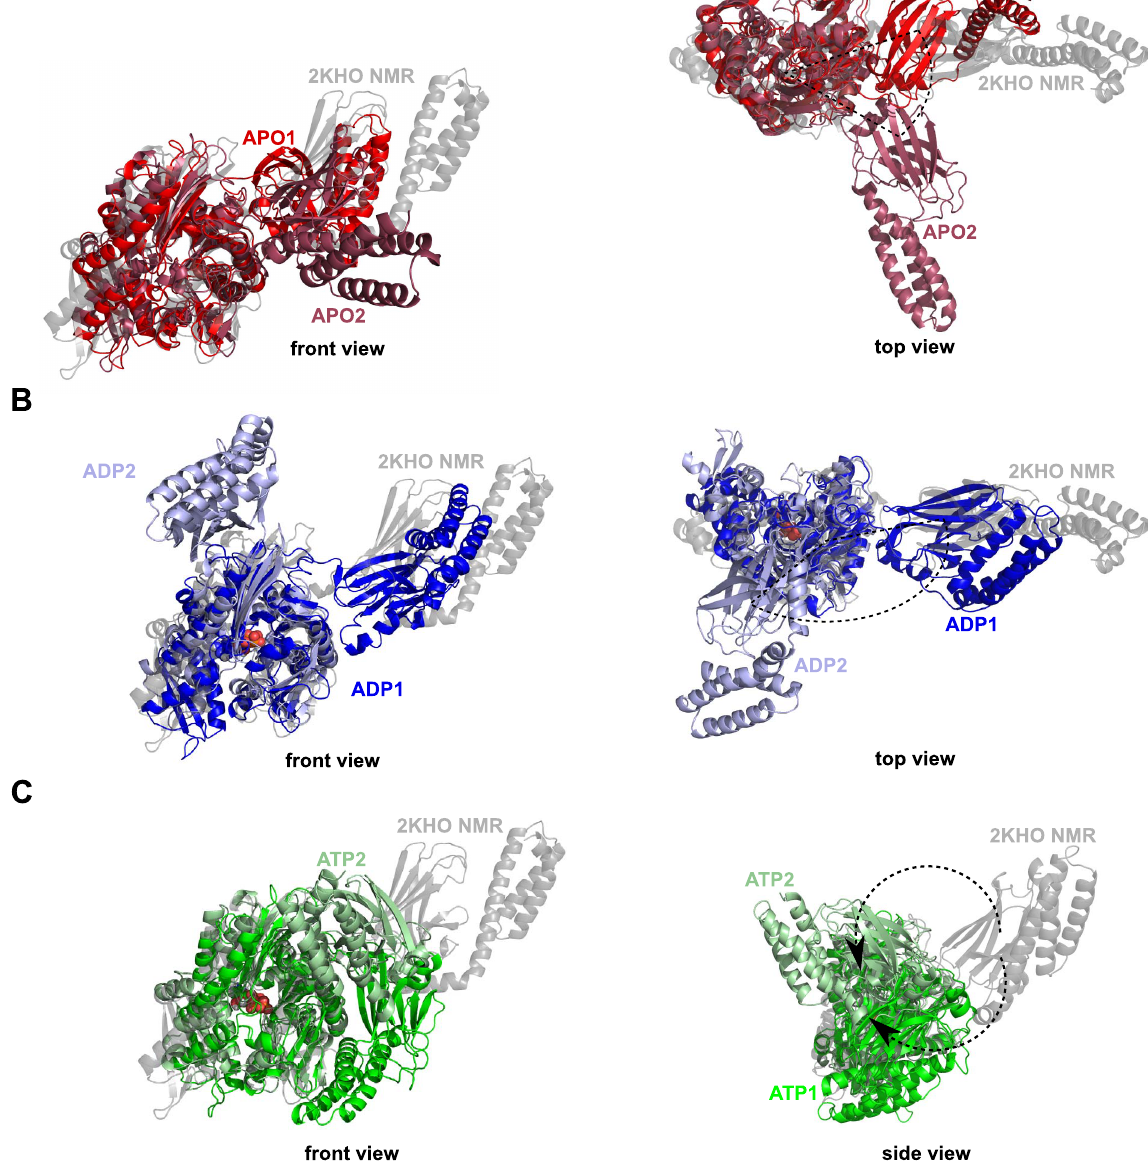
Figure 2. Cartoon representation of the representative structures obtained by MD simulations. A: MD runs APO1 (red) and APO2 (firebrick). B: MD runs ADP1 (blue) and ADP2 (light blue). C: MD runs ATP1 (green) and ATP2 (pale green). The NMR-derived structure used as starting point for the MD simulations (PDB ID: 2KHO) [70] is shown in transparent gray. Representative structures are extracted from a dPCA on the CGDAs c (see Methods section). These figures were prepared with PyMOL